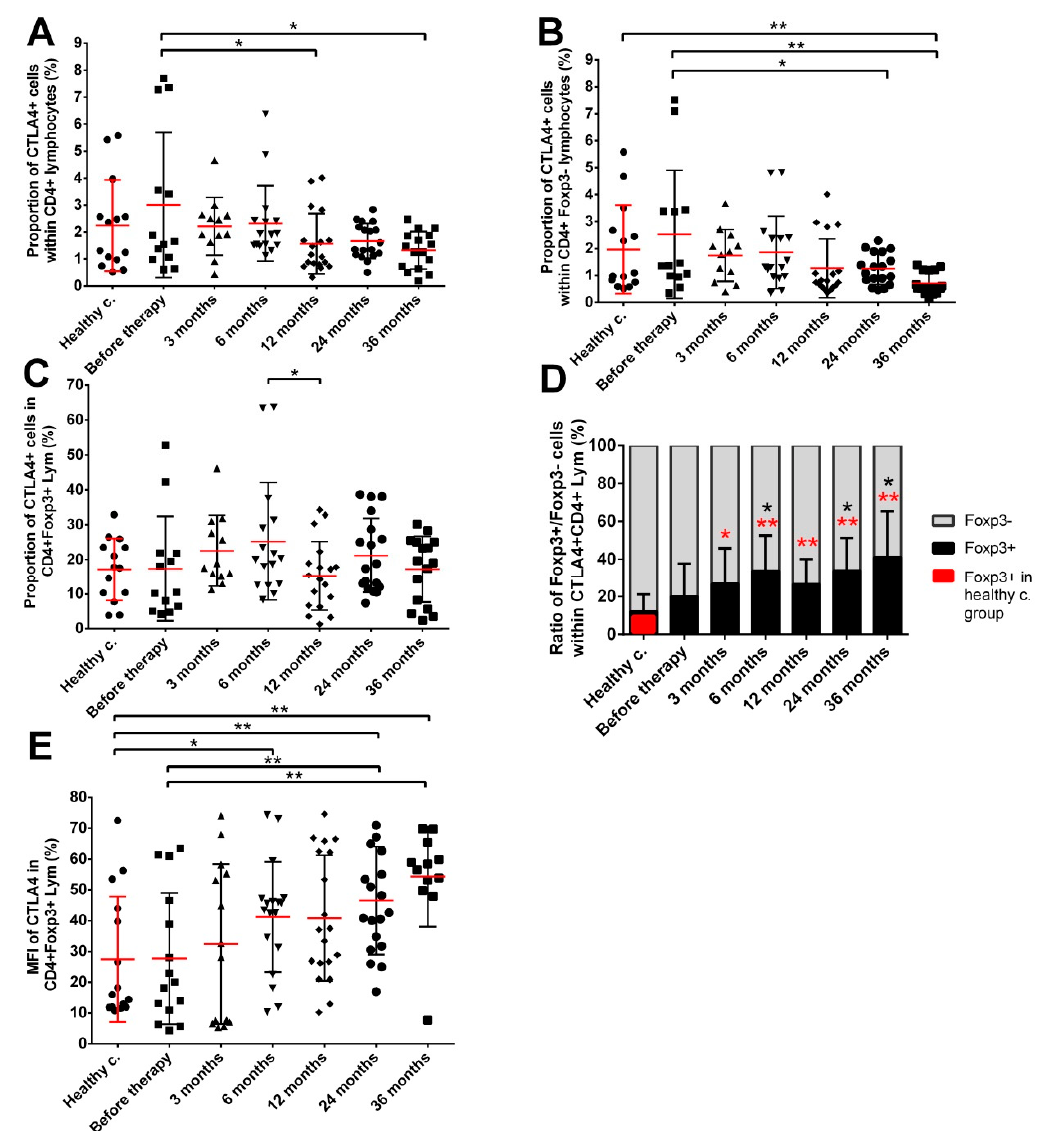
Figure 3. The fraction of Foxp3+ expressing CD4+CTLA4+ cells is progressively increasing in prostate cancer patients. ( A ) CTLA4 expressing CD4+ T cells; ( B ) CTLA4 expressing CD4+ effector T cells; ( C ) CTLA4 expressing Foxp3+ Tregs; ( D ) distribution of Foxp3+ and Foxp3 − cells within the CTLA4+CD4+ lymphocytes. ( E ) CTLA4 expression level on CD4+Foxp3+ Tregs as determined by MFI. Blood collection, processing and immune phenotyping were carried out as described in the Materials and Methods at the indicated time points relative to brachytherapy. n (healthy controls) = 14, n (cancer patients) = 12–18. In Figure ( D ): red asterisks show significant changes compared to healthy controls and black asterisks represent significant changes compared to pre-treatment values. Significant differences were indicated with * ( p < 0.05) and ** ( p < 0.01). MFI: median fluorescent intensity.